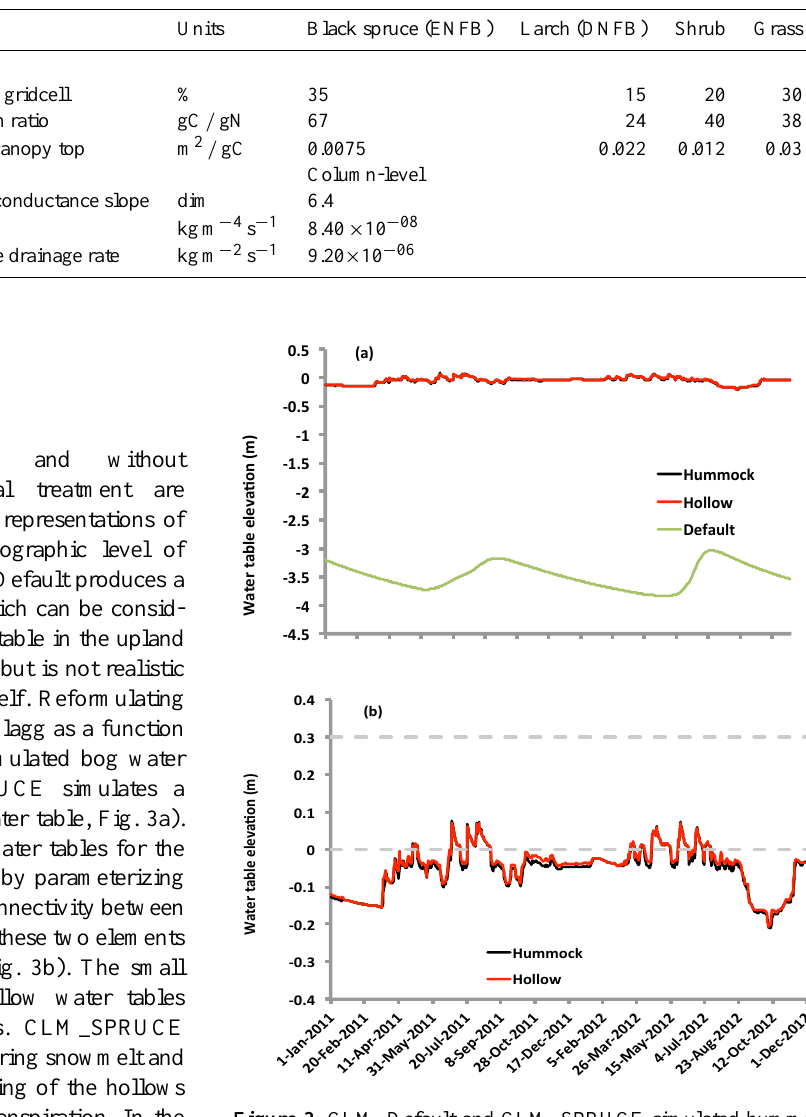
Table 1. Model parameter values which were modified from default values to reflect site-level measurements or optimized parameters. All measured parameters were used to define vegetation physiology, and were applied separately to each of the dominant species or plant functional types (PFTs) included in the simulations. Optimized parameters were generated at the level of the soil column. For the case of the vegetation physiological parameter (mp), this means that the same value was applied for all vegetation types. Optimized hydrologic parameters were applied to both hummock and hollow columns. ENFB = evergreen needleleaf forest – boreal; DNFB = deciduous needleleaf forest – boreal. Units: dim = dimensionless.